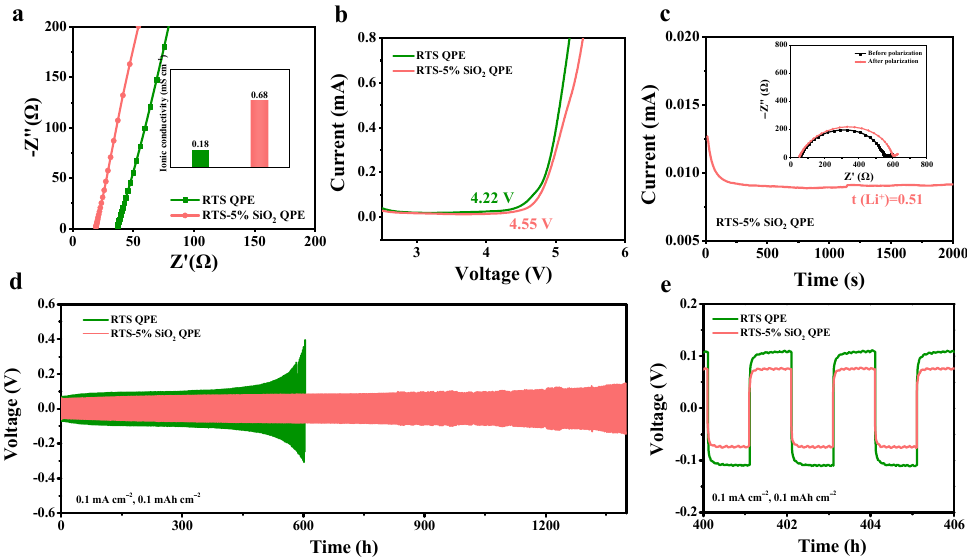
Figure 4. Electrochemical performance of RTS QPE and RTS-5% SiO 2 QPE. ( a ) Nyquist curves of RTS QPE and RTS-5% SiO 2 QPE at room temperature. The embedded histogram shows ionic conductivities; ( b ) Linear sweep voltammetry (LSV) curves of RTS QPE and RTS-5% SiO 2 QPE. The voltage ranges from 2.0 V to 6.0 V at 10 mV s − 1 . ( c ) Current and EIS curves of a Li/RTS-5% SiO 2 QPE/Li battery before and after polarization. ( d ) The galvanostatic charge–discharge cycling curves of Li//Li symmetric cells sandwiched with RTS QPE and RTS-5% SiO 2 QPE at 0.1 mA cm − 2 and 0.1 mAh cm − 2 . ( e ) Zoom-in curves at 400 − 406 h in ( d ). To confirm the compatibility of the electrolyte with lithium metal, Li//Li symmetric cells sandwiched with RTS QPE and RTS-5% SiO 2 QPE are tested at 0.1 mA cm − 2 ,